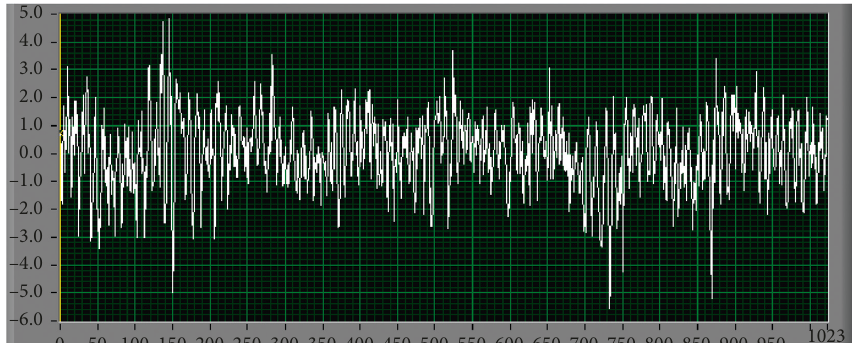
Figure 4: Vibration image in the rolling wear state.